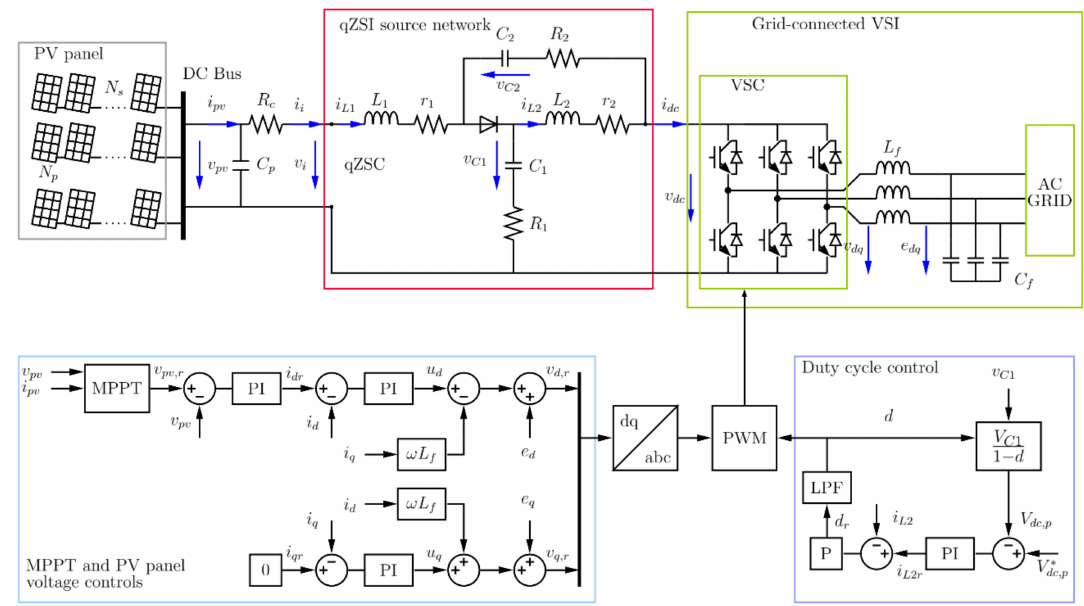
Figure 1. The qZSI-PV power system